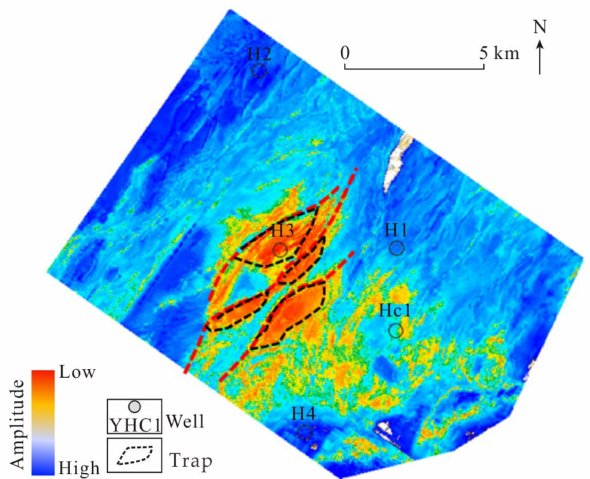
Figure 8. Map view of fault-lithologic traps in K 1 b 1 in the Hari sag. According to the prediction diagram of the K 1 b 2 unconventional reservoir in the Hari sag, the unconventional reservoirs in K 1 b 2 are mainly distributed along two sub-sags in the north and south and gradually decrease from the center of the sag to the slope area (Figure 9). The area of favorable fault-lithologic traps is 99.88 km 2 . A good contiguous distribution has formed in the south sag from Well Hs1 to Well H5. The physical properties in this area have been mainly affected by faults and volcanic activities in Well Hs1 and Well H5. The other relatively good distribution area is located around Well H6, belonging to the northern sub-sag of the Hari sag.